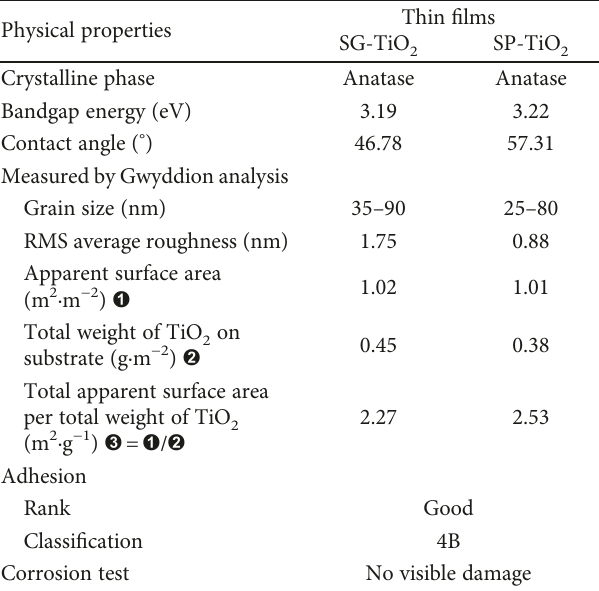
Table 2: Physical properties of the SG-TiO photocatalytic thin fi